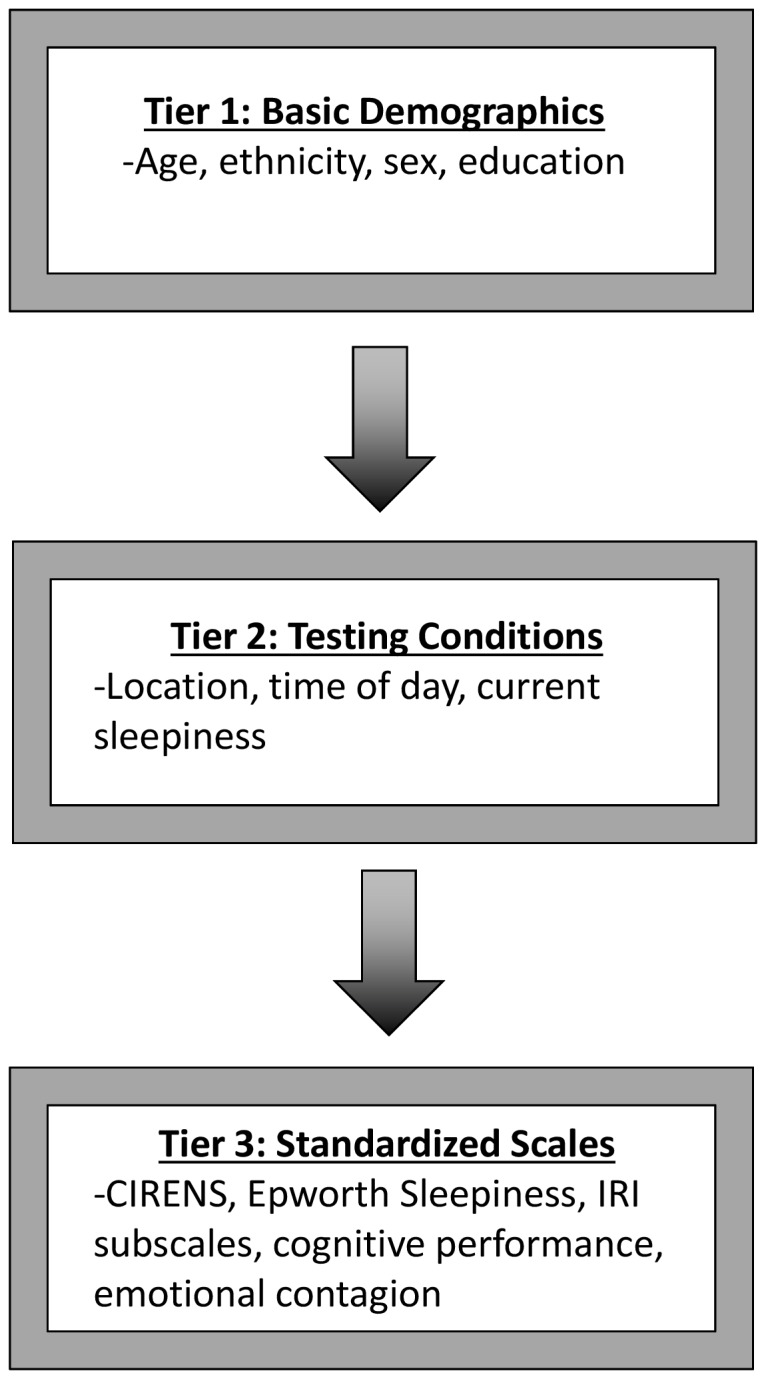
Flow chart of analysis procedure.Regression analyses were performed in three tiers: Tier 1 tested basic demographics as covariates, Tier 2 added testing conditions, and Tier 3 included measurements for standardized scales.